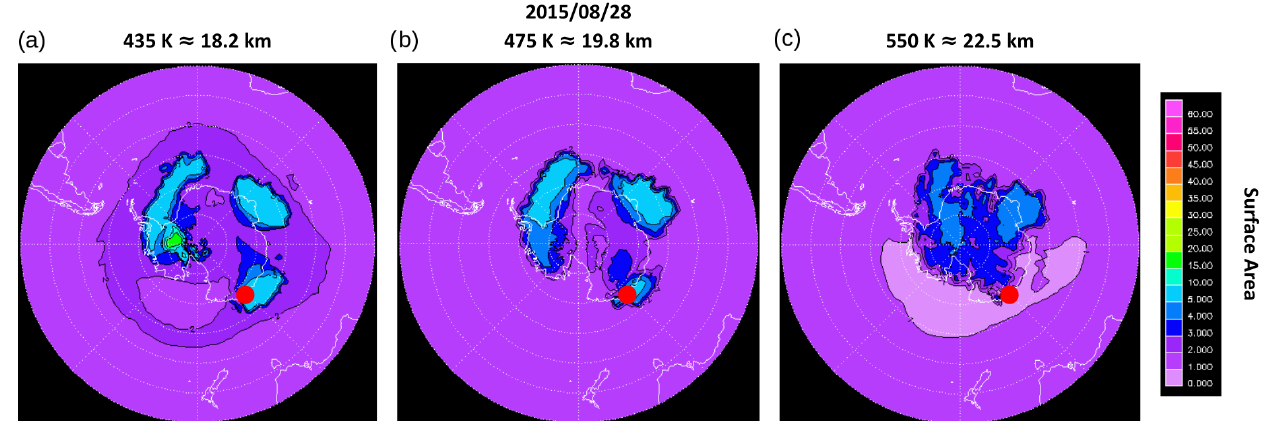
Figure A1. PSC surface area (µm 2 cm − 3 ) maps from the Reprobus model for 28 August 2015 at 435K (a) , 475K (b) and 550K (c) . DDU location is indicated by the red dots.